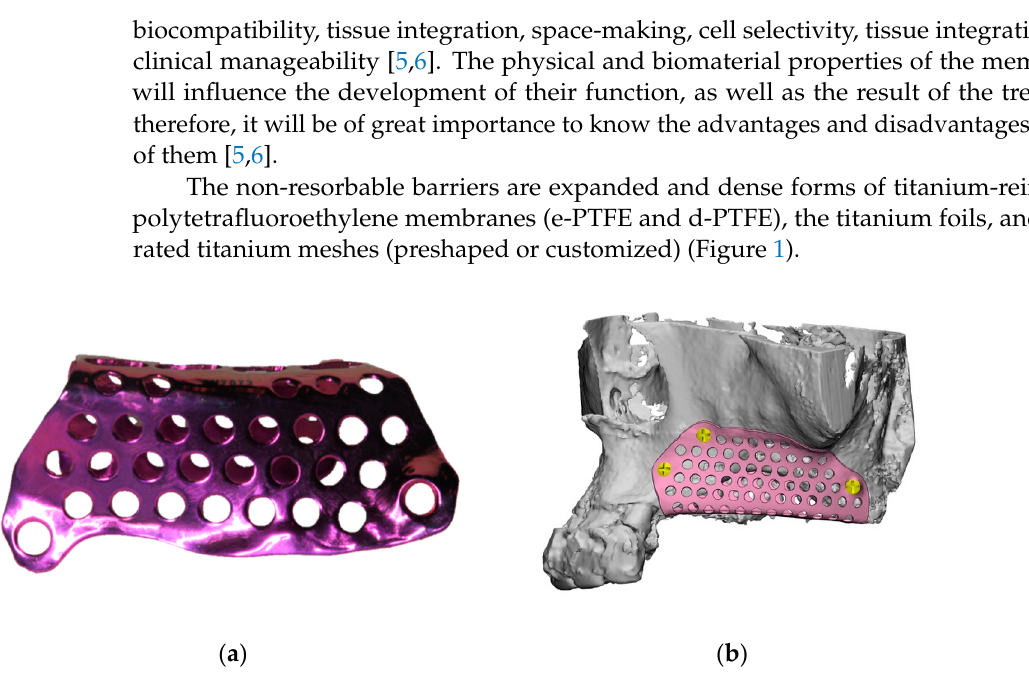
Figure 1. ( a ) Custom-made titanium mesh (AVINENT ®® Digital Health); ( b ) Use of Computer-Aided Design (CAD) and Computer-Aided manufacturing (CAM)to design custom-made devices for guided bone regeneration (GBR).